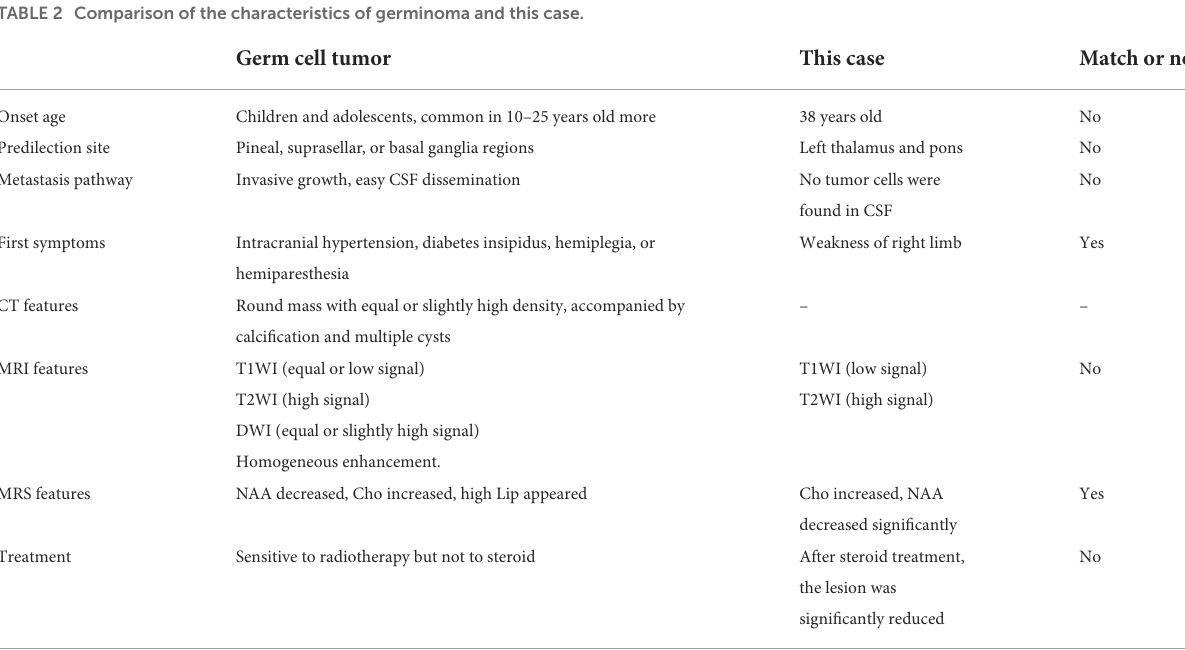
TABLE 2 Comparison of the characteristics of germinoma and this